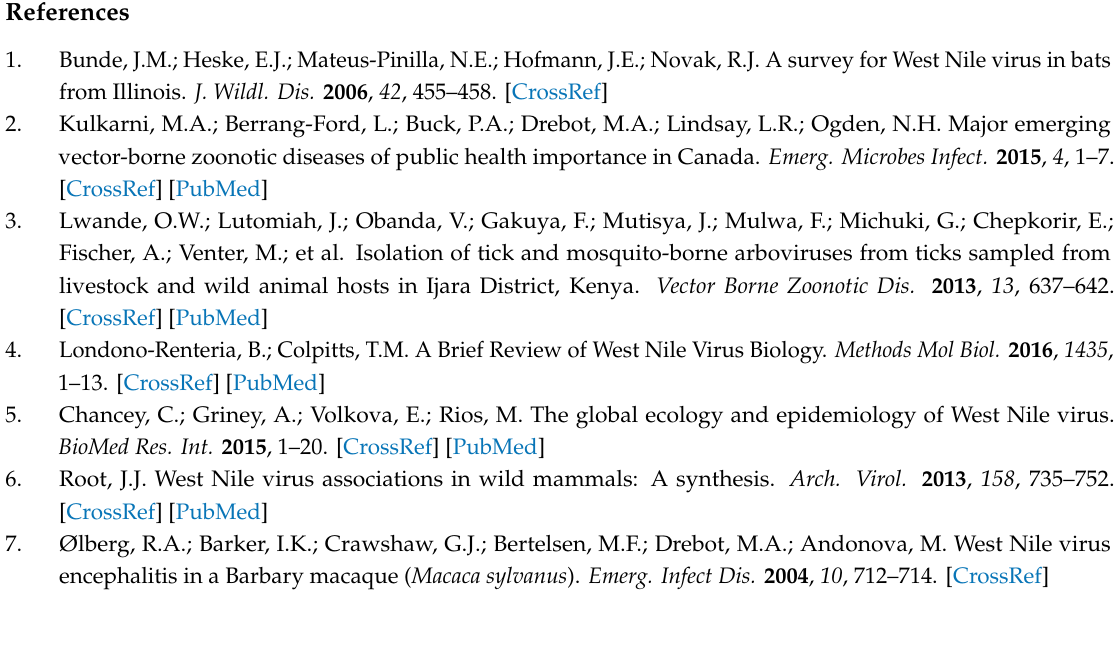
Table S1: Sequence and location used for RT-PCR to amplify WNV gene, Table S2: List of references strains used in the phylogenetic and pairwise analysis. Figure S1: Pairwise percent identity between nucleotide (black) and amino acid (blue) sequences of selective WNV strains with local detection. The identity percentage range was set from high, medial and low similarity as indicated by light green, yellow and red color,